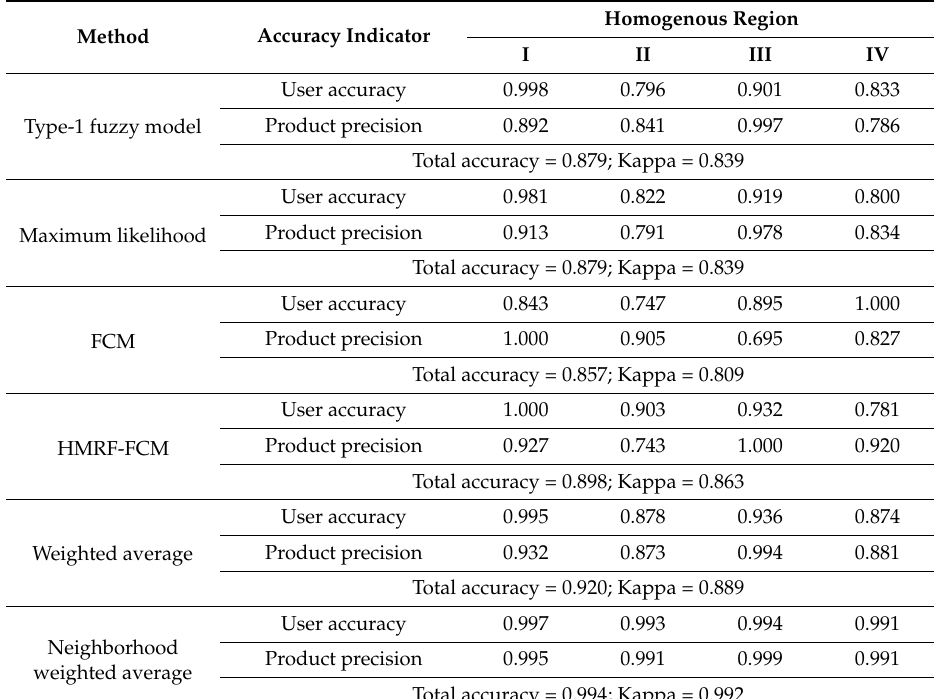
Table 2. User accuracy, product precision, user accuracy, and Kappa